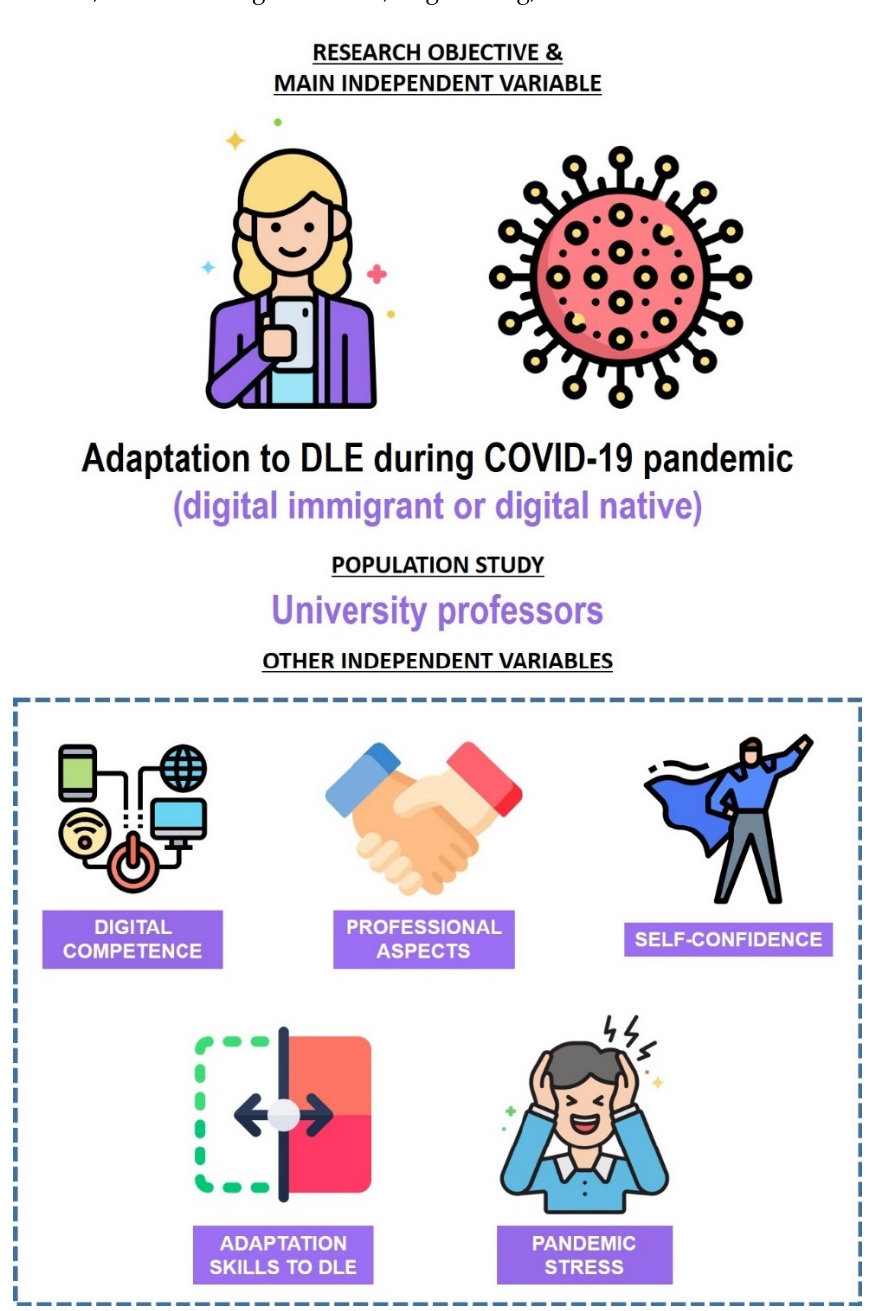
Figure 4. Research objective and variables.